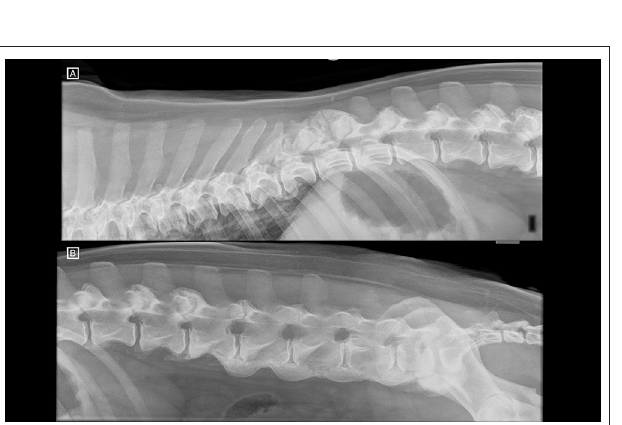
FIGURE 3 | (A) Right lateral radiographs of the thoracolumbar and (B) lumbosacral spine. T13 has the last pair of ribs. Notice the new bone formation around the spinous process of T11 and T12 and the articular processes at T11–12 and T12–13. The lumbar vertebrae appear decreased in radiopacity, and the dorsal cortex of the vertebral bodies is not identified. There is ventral bridging spondylosis along the ventral aspect of the lumbar spine, from L3 to LS (ventrally to the endplates but extending ventrally to the vertebral body as well) causing a flowing ossicification consistent with diffuse idiopathic skeletal hyperostosis (DISH). There is further ventral bridging spondylosis at the level of T7–T8 and T9–T11. intradural space (intradural, extramedullary). No neoplastic invasion of the hyperostotic cortical bone was noted. The